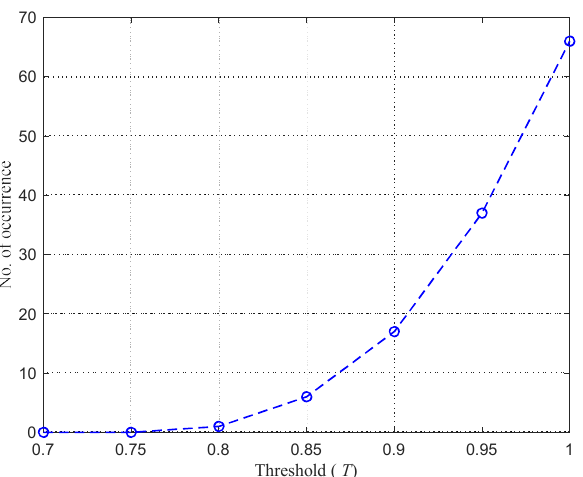
Figure 16. Number of responses that have maximum fidelity factor less than or equal to the given threshold T .